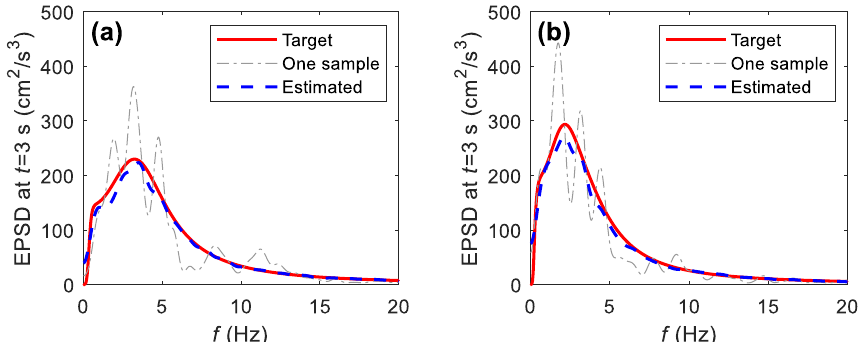
Fig. 6 Comparison of the auto-EPSD function in the numerical example at t